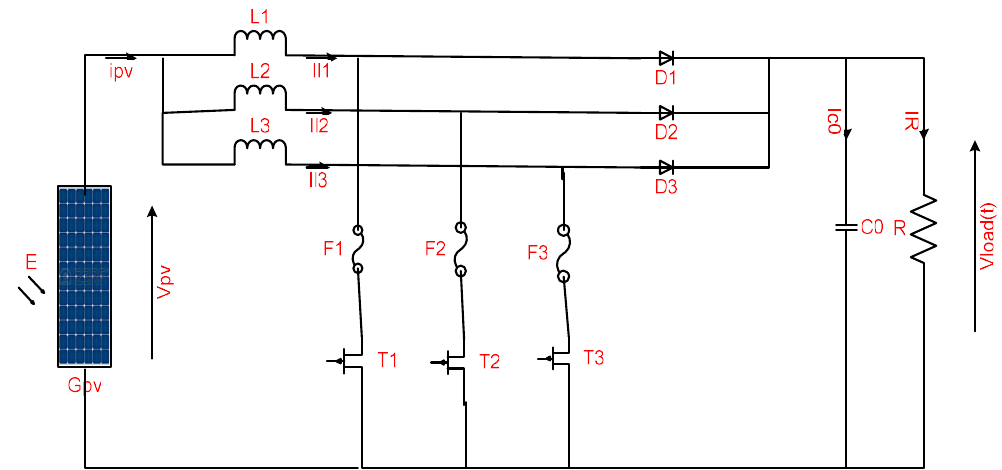
Figure 7. Topology of the converter.